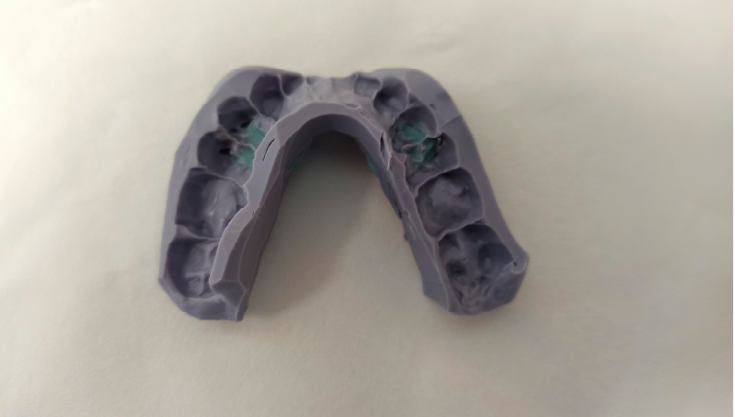
Figure 1. Soft stabilization splint example.